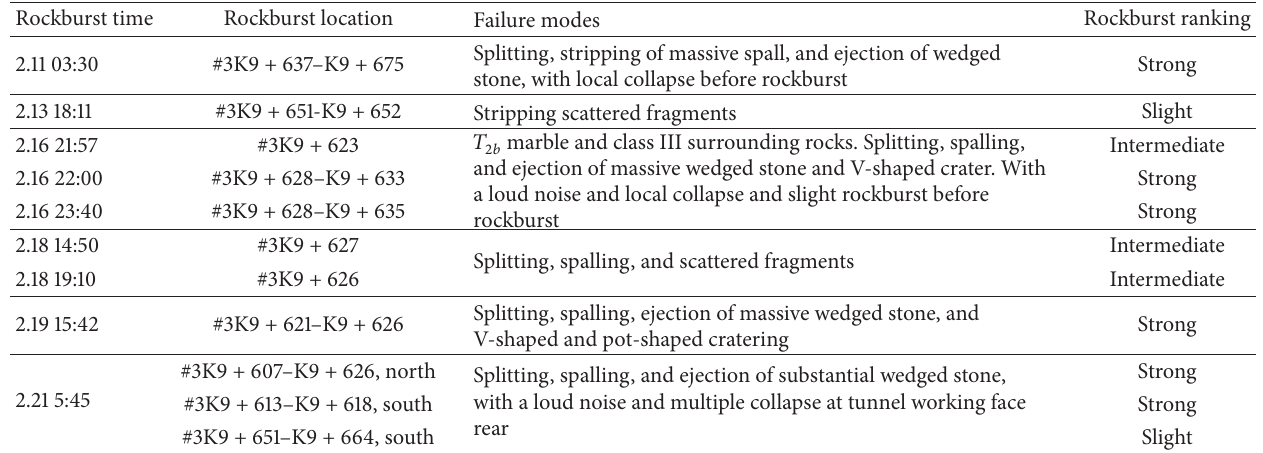
Table 3: On-site records of rockburst within the tunnel section of #3K9 + 770–K9 + 607. Rockburst time